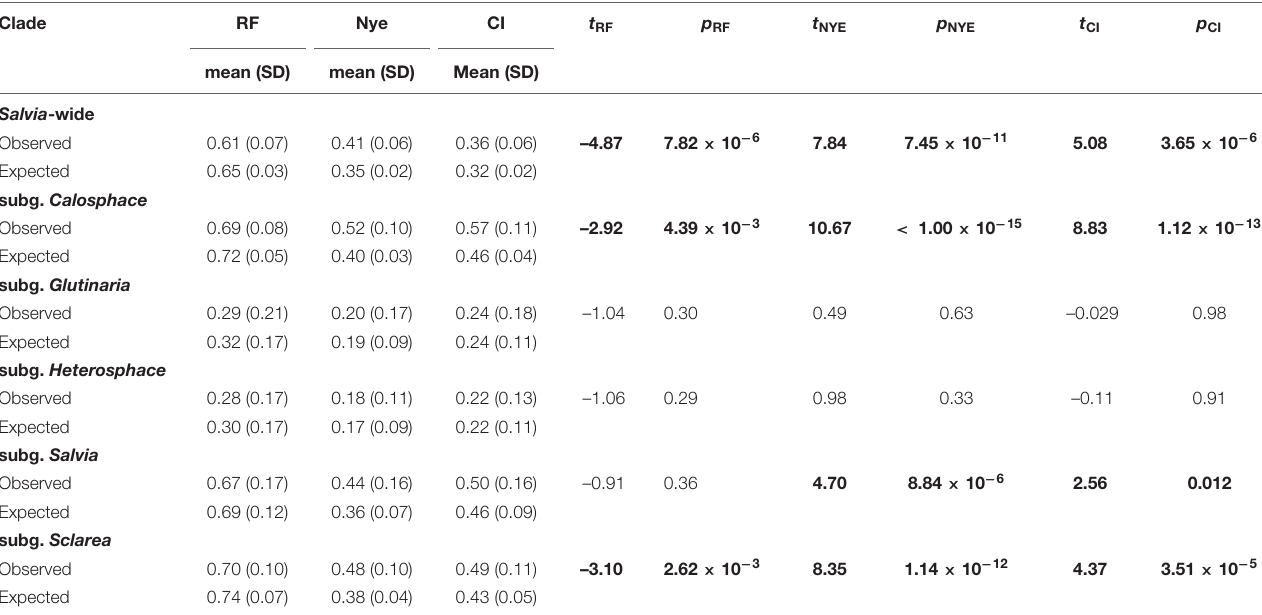
The three different distance metrics, RF, Nye, and CI, compare the topology of the gene trees to the ASTRAL species tree, and we considered the branching order alone. The gene trees are either empirical trees that can be rooted and have clade occupancy > 75% of sampled tips (observed) or 1,000 gene trees simulated under the multispecies coalescent using the ASTRAL species tree (expected). The distances were normalized so that they ranged from 0 to 1, with 0 indicating complete agreement between a gene tree and the species tree. The t-values and associated p-values for each distance metric/clade combination are based on Welch’s t-test with the hypothesis that the mean tree distance for the observed and expected gene trees are equal, or in other words, that the tree distances based on empirical data are what would be expected under incomplete lineage sorting alone. Significant t/p-values at α = 0.05 are indicated in bold.